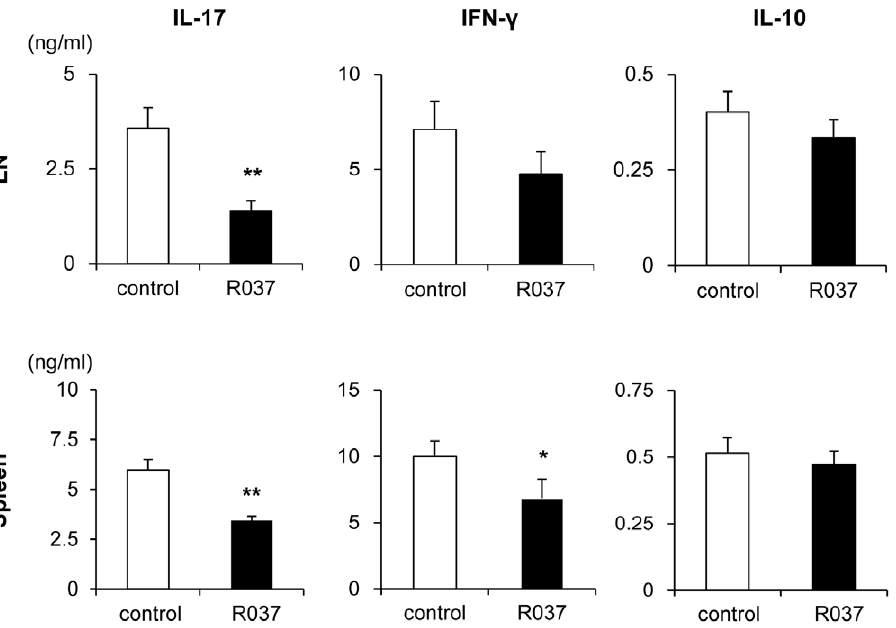
Figure 3. Administration of R037 inhibits the secretion of inflammatory cytokines. Lymphocytes were isolated by draining lymph nodes (dLN) and spleens of C57BL/6 mice on day 11 after immunization and restimulating with MOG 35–55 for 72 h. IL-17, IFN- c and IL-10 in the culture supernatants were assayed by ELISA. Decreased IL-17 production by both dLN cells and splenocytes and decreased IFN- c by splenocytes were observed in the R037-treated group. Data are shown as mean + SEM from a representative of three independent experiments for 6 mice in the R037- treated and 8 in the control groups. **p # 0.01; *p # 0.05.